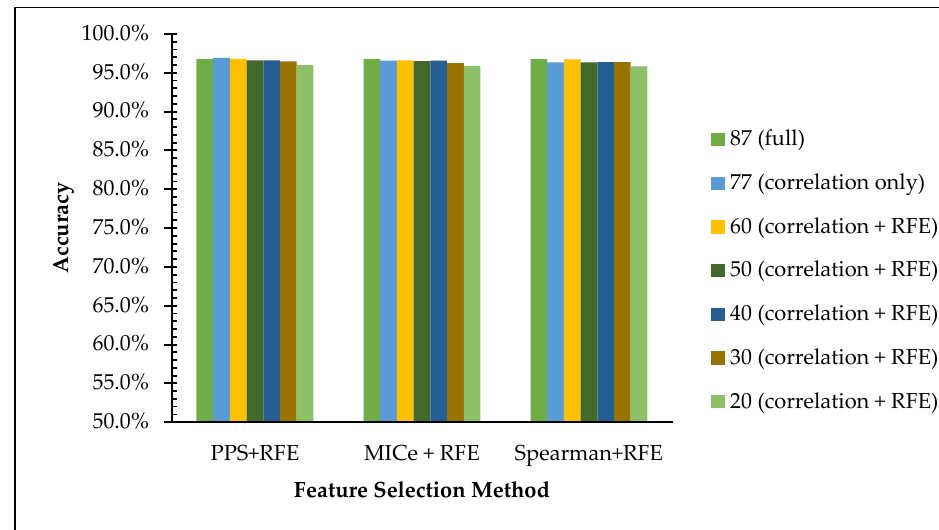
Figure 5. Comparison of all feature subset scenarios for dataset 1.